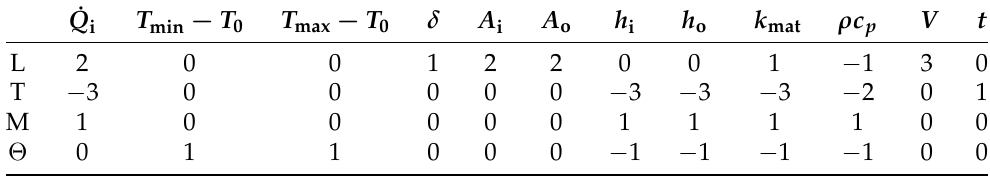
Table 1. Dimensional matrix used to derive the non-dimensional heat